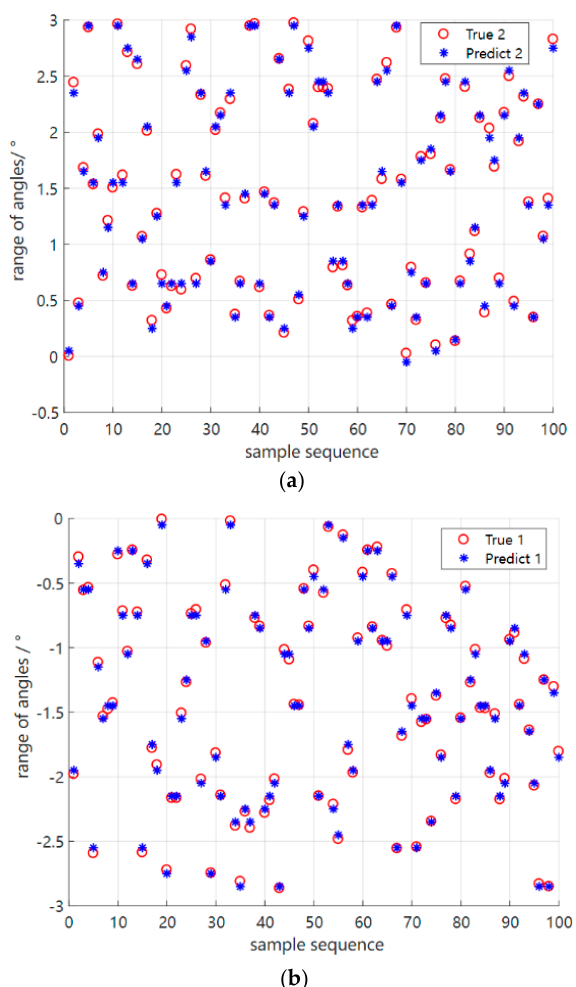
Figure 11. Comparison of RMSE of S2S network meta − reinforcement learning algorithm with other methods in the original environment.